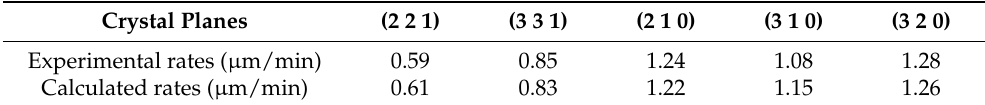
Table 1. Calculated and experimental rates of crystal planes under the experimental condition (the etching solution is 34 wt% KOH and the etching temperature is 71 °C) [29]. Crystal Planes